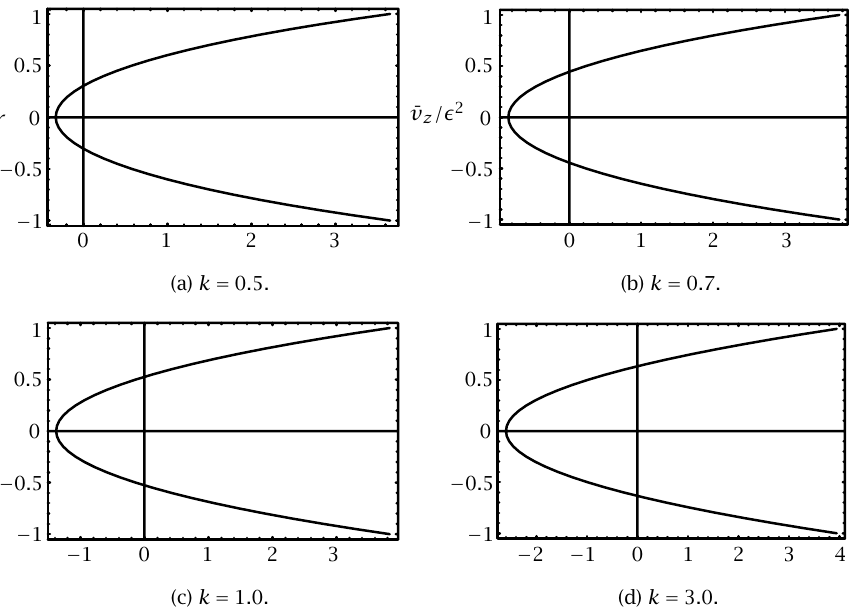
Figure 6.10 . The effect of the permeability parameter k on the mean- velocity distribution and reversal flow at Re = 1 . 0, (∂P/∂z) 2 = − 10 . 0, and α = 0 . 1.